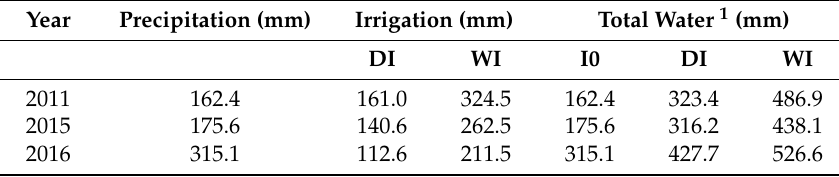
Table 1. Precipitation and irrigation water during the tomato cropping cycle from planting to harvest.